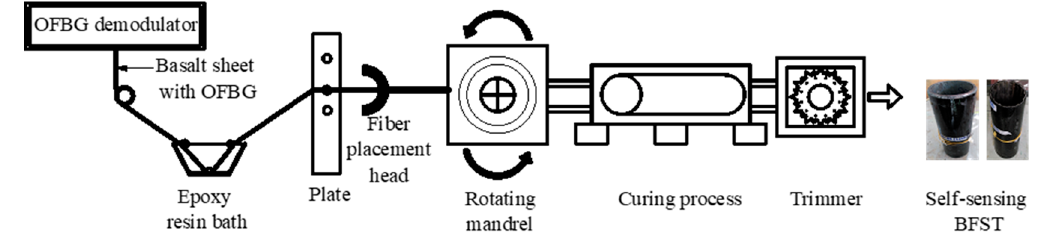
Figure 2. Manufacturing process for the self-sensing basalt fiber-reinforced polymer (FRP)–steel composite (BFST).